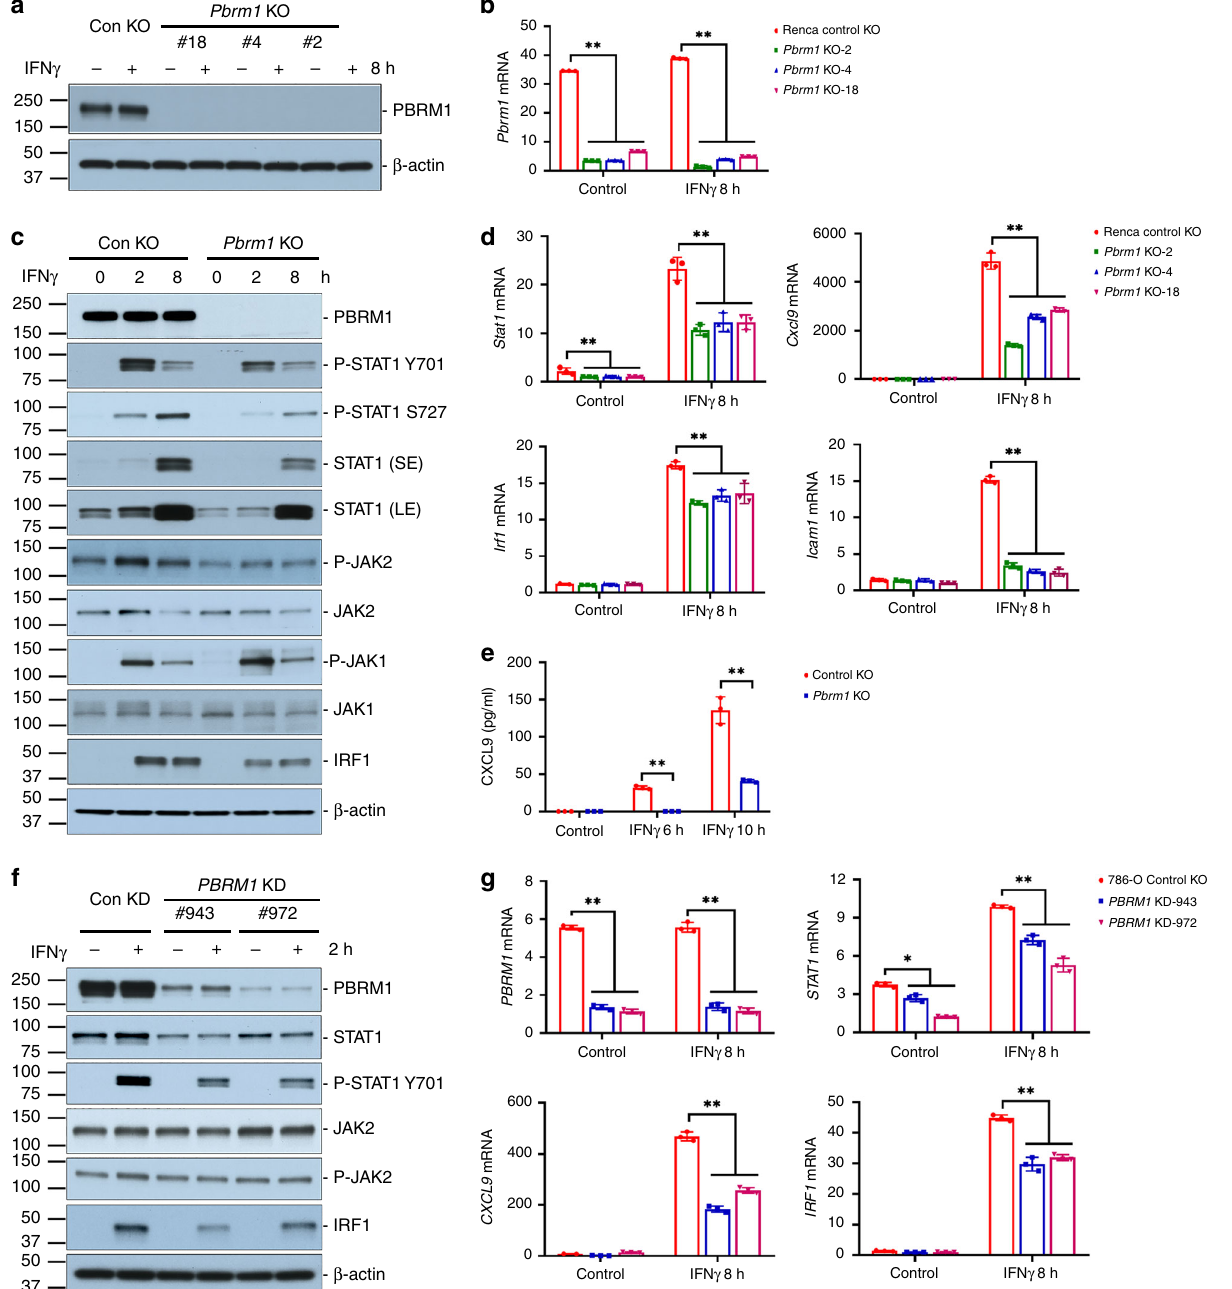
Fig. 1 PBRM1/Pbrm1 de fi ciency reduced IFN γ -STAT1 activity in Renca cells and 786-O cells. a Pbrm1 knockout validation in Renca cells at protein levels by western blot, and b at mRNA levels by real-time PCR. Renca cell were treated with or without 1 ng/ml IFN γ for 8 h. c IFN γ -induced JAK-STAT1 expression and phosphorylation in Renca cells. Control KO or Pbrm1 KO (clone #18) Renca cells were treated with 1 ng/ml IFN γ for 2 or 8 h. Cell lysates were analyzed by immunoblot using antibodies against PBRM1, STAT1, P-STA1 Y701, P-STAT1 S727, JAK2, P-JAK2 Y1007/1008, JAK1, P-JAK1 Y1034/ 1035, IRF1. β -actin was used an internal control. d IFN γ -induced gene expression in Renca cells. Control KO or Pbrm1 KO (clone #18) Renca cells were treated with 1 ng ml IFN γ for 8 h. mRNA expression of Stat1 , Cxcl9 , Irf1 , and Icam1 were detected by real-time PCR. Gapdh was used as internal control. e IFN γ -induced CXCL9 secretion. Renca cells were cultured in serum-free medium and treated with 1 ng/ml IFN γ for 4 or 10 h. The concentration of CXCL9 was analyzed using Quantikine ® ELISA kit. f IFN γ -induced JAK-STAT1 expression and phosphorylation in 786-O cells. Control knockdown (Con KD) or PBRM1 knockdown ( PBRM1 KD) 786-O cells were treated with or without 10 ng/ml IFN γ for 2 h. Cell lysates were analyzed by immunoblot using antibodies against PBRM1, STAT1, P-STA1 Y701, JAK2, P-JAK2 Y1007/1008, and IRF1. β -actin was used an internal control. g IFN γ -induced gene expression in 786-O cells. 786-O cells were cultured in DMEM with 10% FBS, and treated with 10 ng/ml IFN γ for 8 h. mRNA expression of STAT1 , CXCL9 , and IRF1 were detected by real-time PCR. GAPDH was used as internal control. Unpaired t -test was performed with GraphPad Prism 7.03. * P < 0.05 and ** P < 0.001, compared with control knockout or knockdown cells. All data are representative of three independent experiments. Data in the bar graphs represent mean ± S.D., n = 3. Source data are provided as a Source Data fi